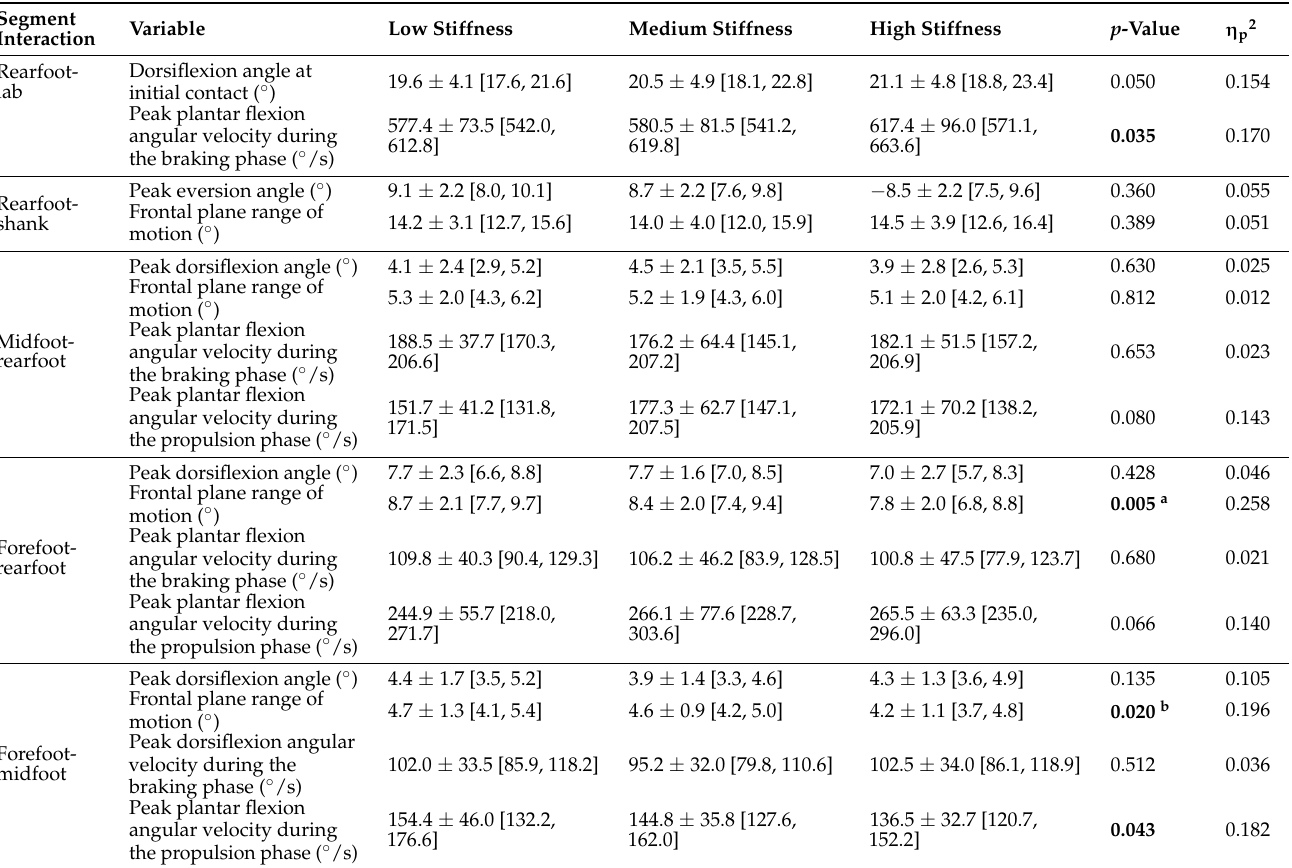
Table 2. Multi-segment kinematic variables (Mean ± SD [95% confidence interval]) of experimental shoes. A significant main effect p -value is